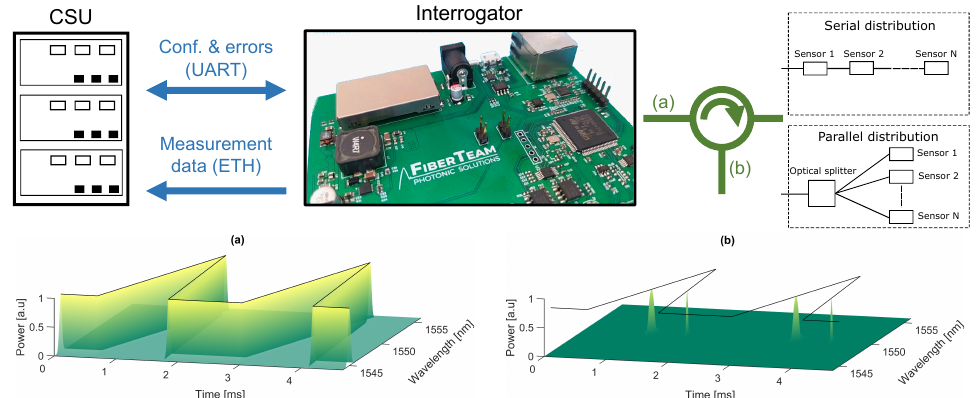
Figure 1. Architecture of the measurement system. Communication between CSU and the inter- rogator is based on Ethernet and USB-UART. The interrogator can be used to analyze serially or parallelly distributed sensor networks. In ( a ), the simulation of an output signal in wavelength and time domains is shown. Meanwhile, in ( b ), the simulation result of a received signal from one FBG sensor is